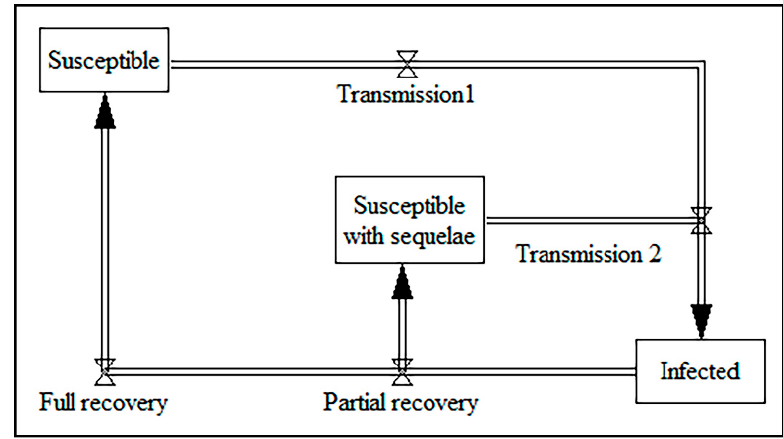
Figure 9. The core part of the stock-flow diagram for chlamydia.